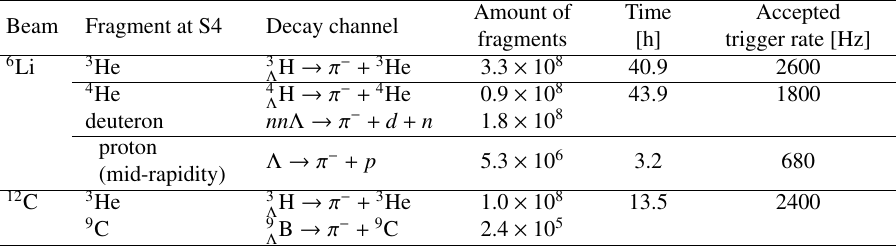
Table 2. Acquired fragments at the S4 focal plane in the WASA-FRS HypHI experiment. Decay channels of the objective hypernuclei are listed for each